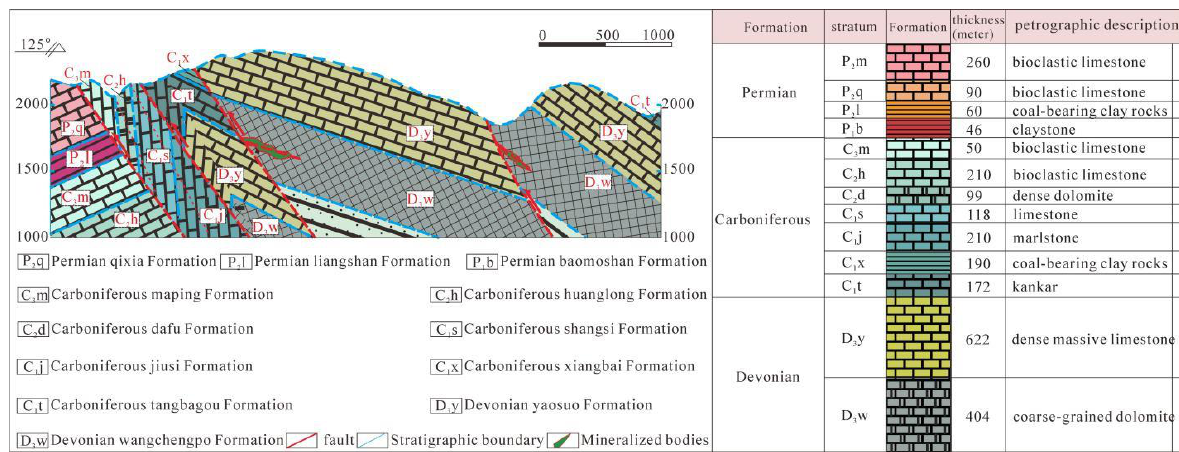
Figure 3. Cross-section map of Lekai Pb-Zn deposit in SYG Pb-Zn metallogenic province [30].